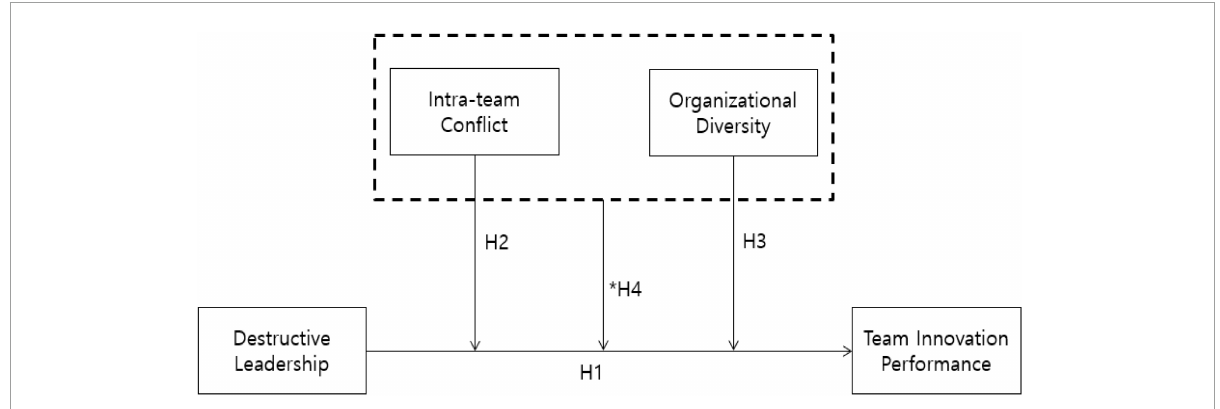
FIGURE1 Hypothesized research model. *Three-way interaction